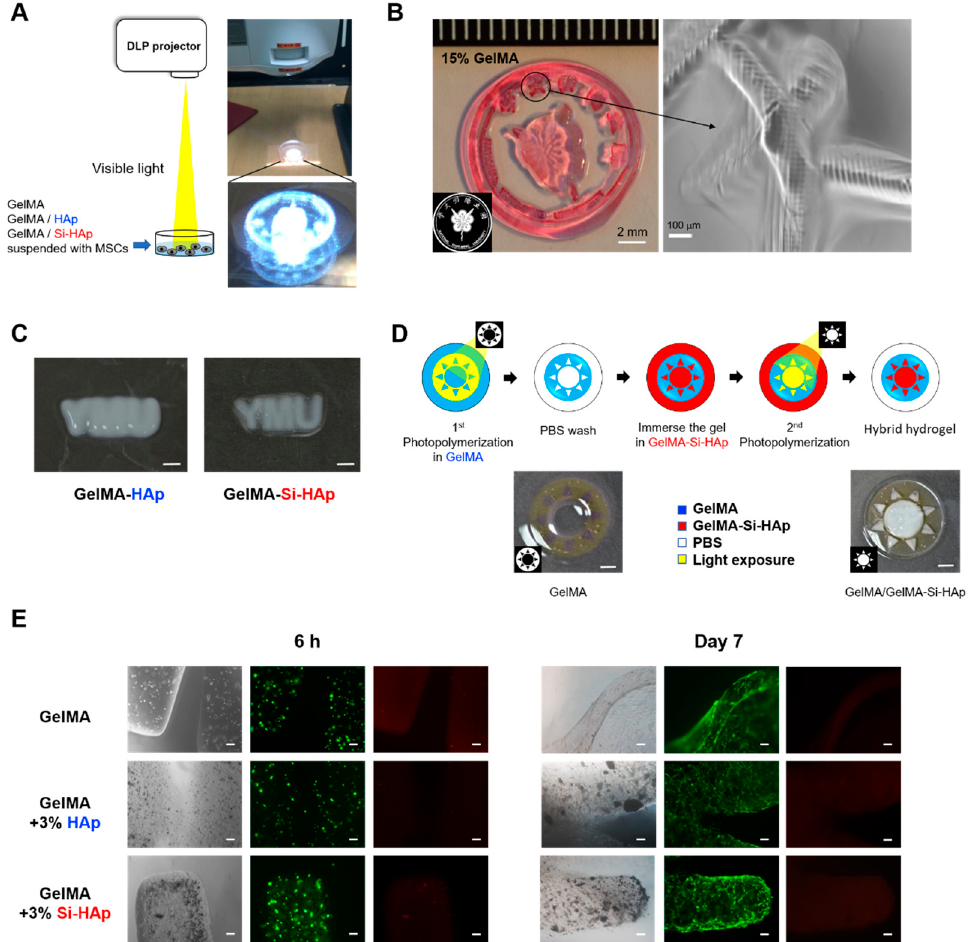
Figure 6. GelMA composite hydrogels were fabricated by visible light projection. ( A ) Schematic of the photolithographic method that was to construct GelMA-based hydrogels with a digital light processing (DLP) projector. ( B ) 15% cell-free GelMA hydrogel fabricated into the logo of National Yang-Ming University by projection (stained with neutral red). Scale bar, 2mm. Right, the hydrogel was observed through optical microscopy. Scale bar, 100 µm ( C ) 15% GelMA with 3% HAp and GelMA with 3% Si-HAp composite hydrogels developed using the DLP-based projector for 40 s). Scale bar, 5 mm. ( D ) Sequential fabrication of GelMA and GelMA-Si-HAp composite hydrogels in a hybrid pattern. Scale bar, 5 mm. ( E ) Cell viability assay of MSCs encapsulated in hydrogels through photolithography after 6 h and 7 days of incubation. green, calcein AM, red, ethidium homodimer -1 . Scale bar, 100 µm.